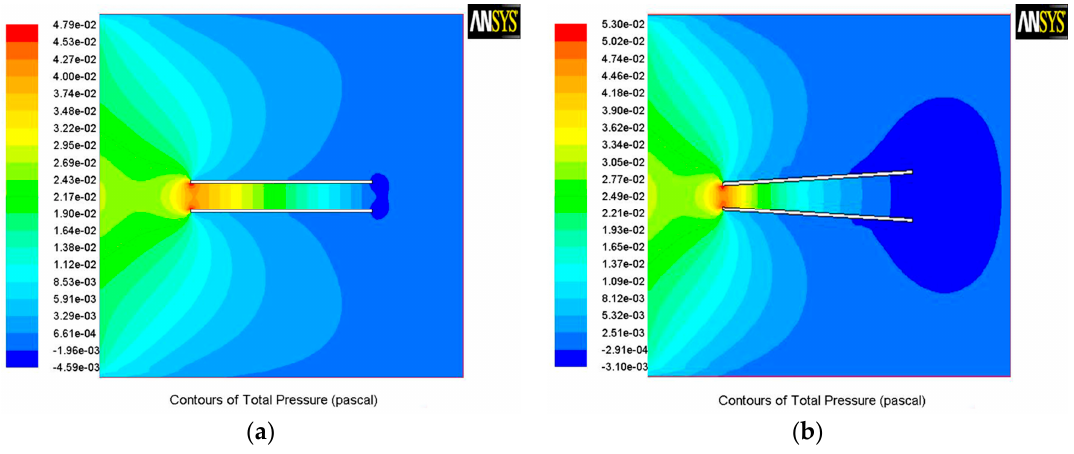
Figure 6. The pressure contours of two differently shaped micromotors with all of the same boundary conditions: ( a ) cylindrical micromotor; and ( b ) conical micromotor.